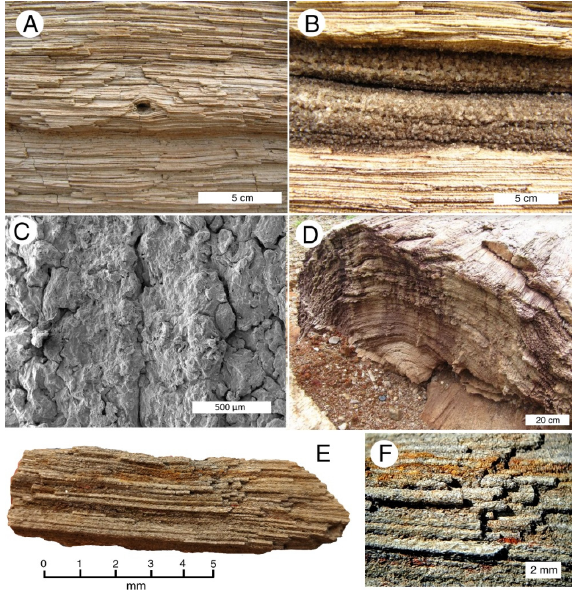
Figure 9. Quartz-mineralized wood from Tak log BT-7. Individual cells are coated with subhedral quartz crystals, with incomplete mineralization of intercellular spaces. ( A ) Field photo showing wood grain pattern. ( B ) Zone where quartz crystals are relatively large. ( C ) SEM image, longitudinal orientation. ( D ) Transverse view of log #7 fracture. Mineralization produced brittleness that allowed cross-grain fracture but partially open intercellular spaces resulted in an uneven surface. ( E , F ) Crystalline texture is readily apparent, but absence of mineralization of intercellular spaces allows individual wood fibers to be